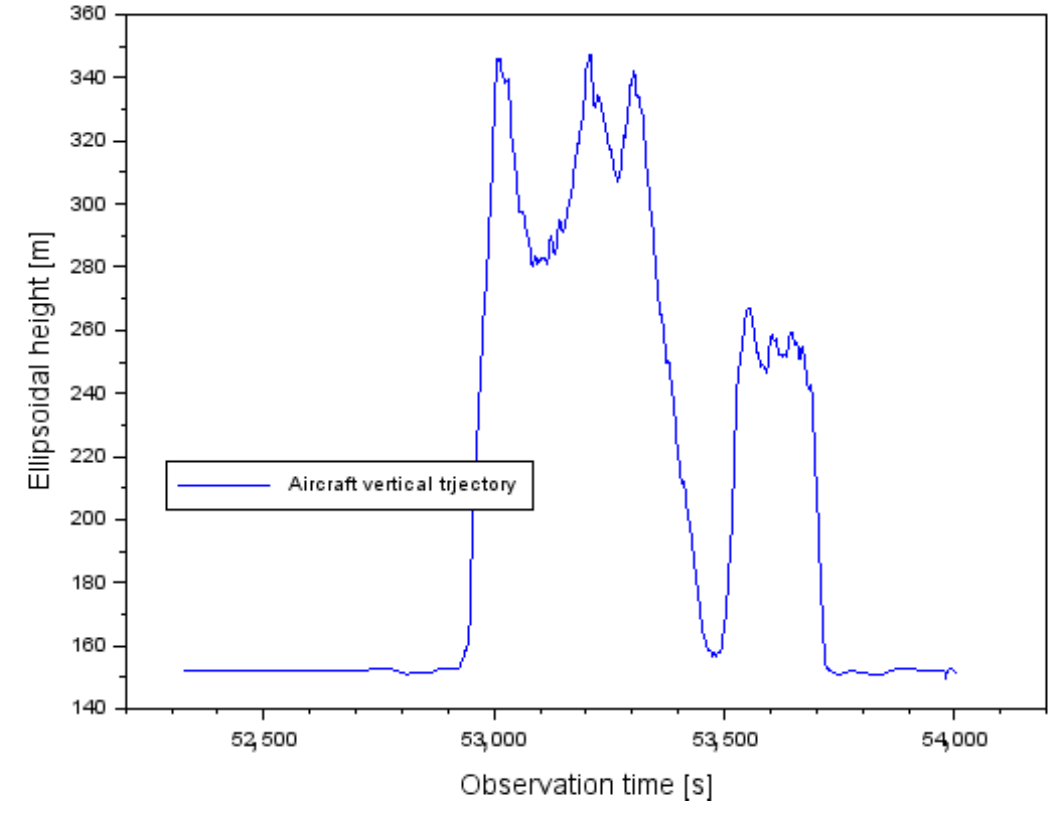
Figure 6. Vertical trajectory of Cessna 172